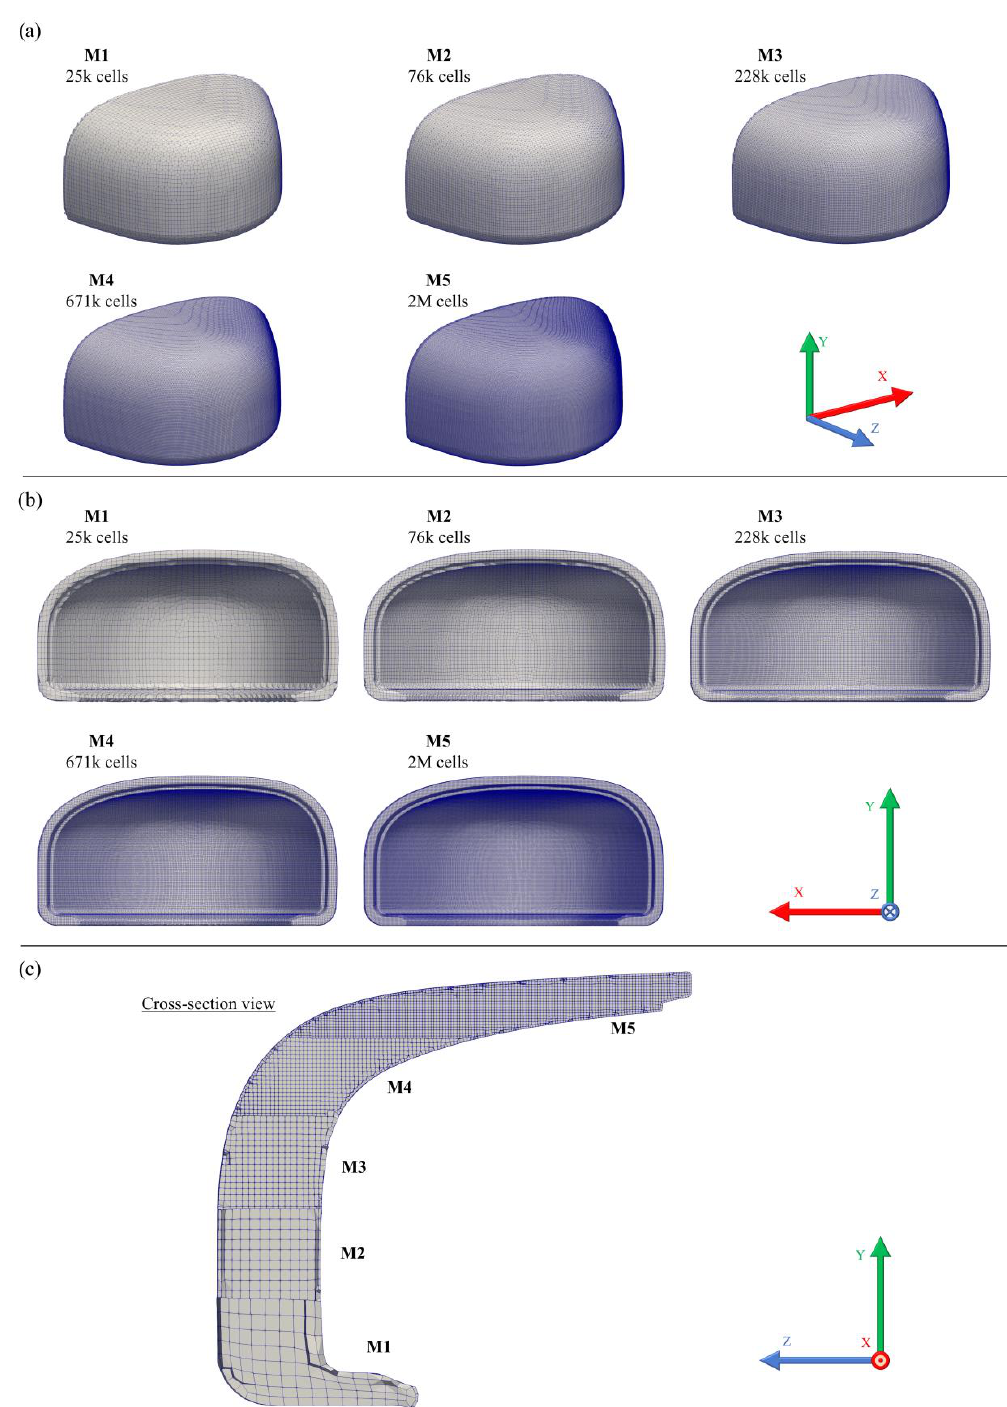
Figure 2. Toe cap meshes (M1 to M5) used on the mesh sensitivity analysis: ( a ) isometric view, ( b ) back view, and ( c ) cross-section